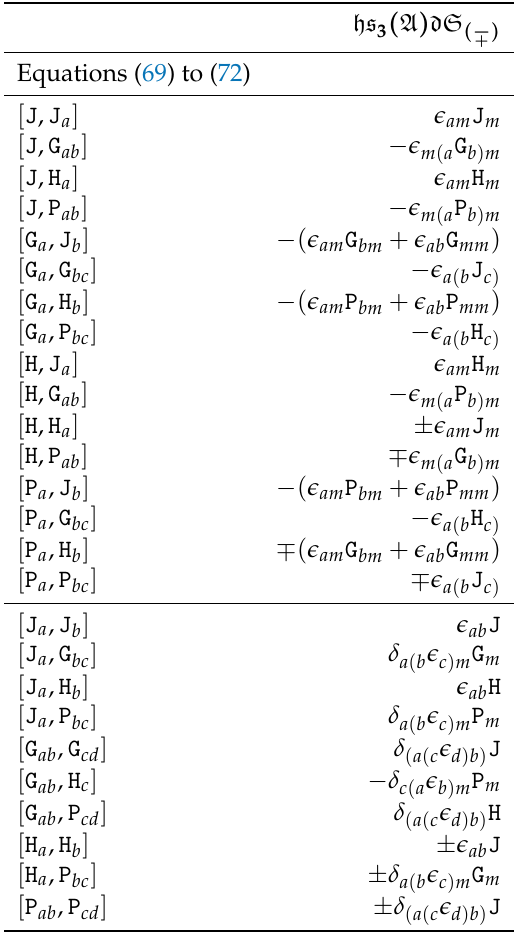
Table 2. Higher spin versions of the (A)dS algebras. The upper sign is for AdS and the lower sign for dS.